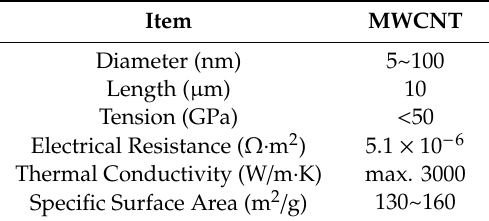
Table 3. Physical properties of MWCNTs. Table 4. Mixture proportions (mass